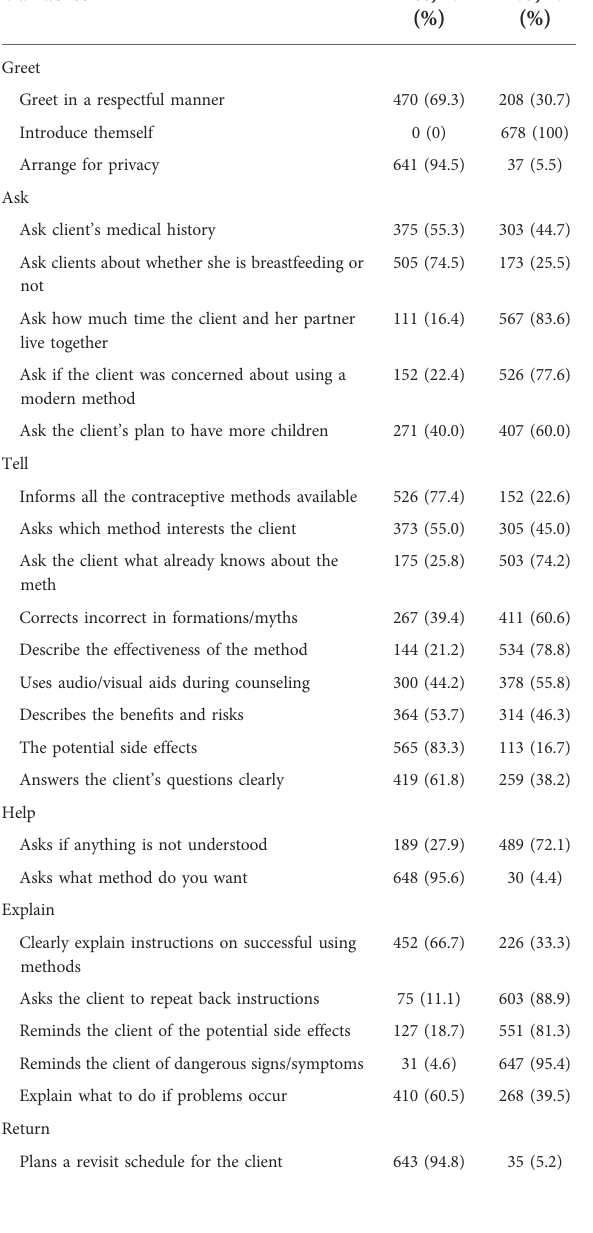
TABLE 2 Responses of clients about family planning counseling quality among women attending family planning services at health